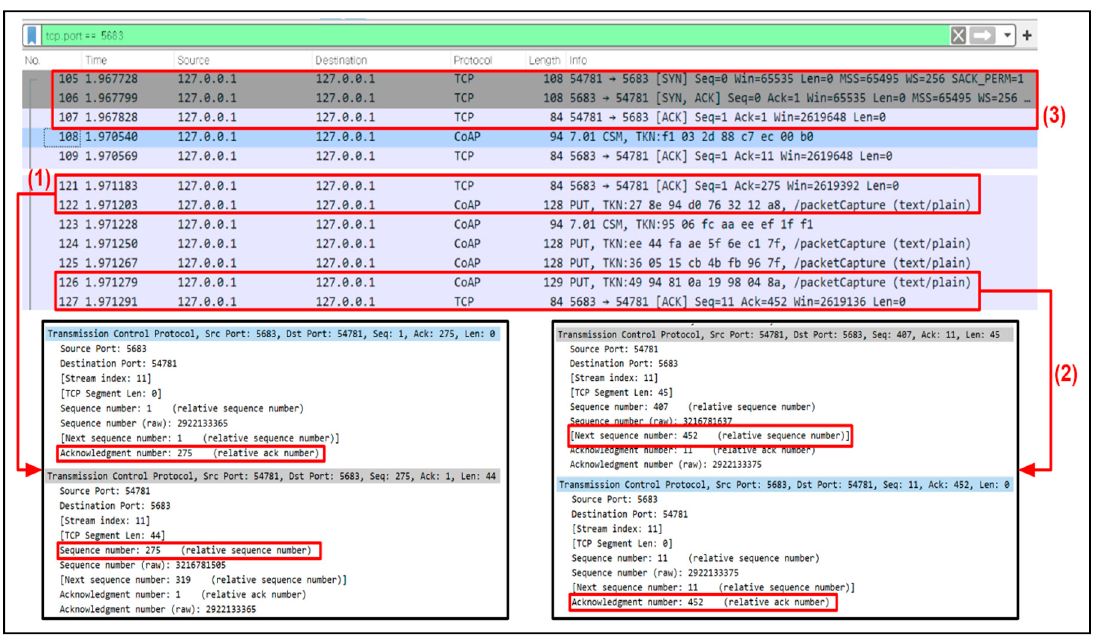
Figure 6. Packet analysis for CoAP over TCP transmission.